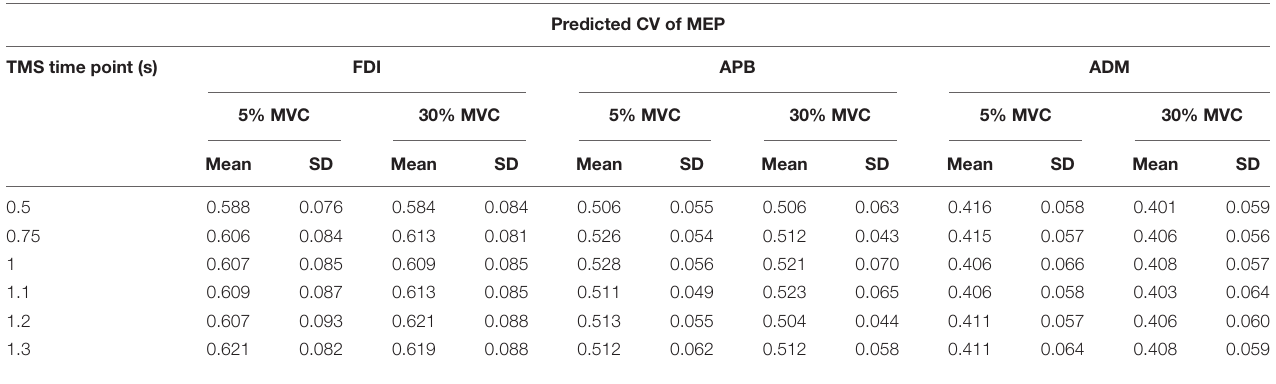
TABLE 1 | Predicted CV (CV PRED ) of MEP for each TMS time point and force